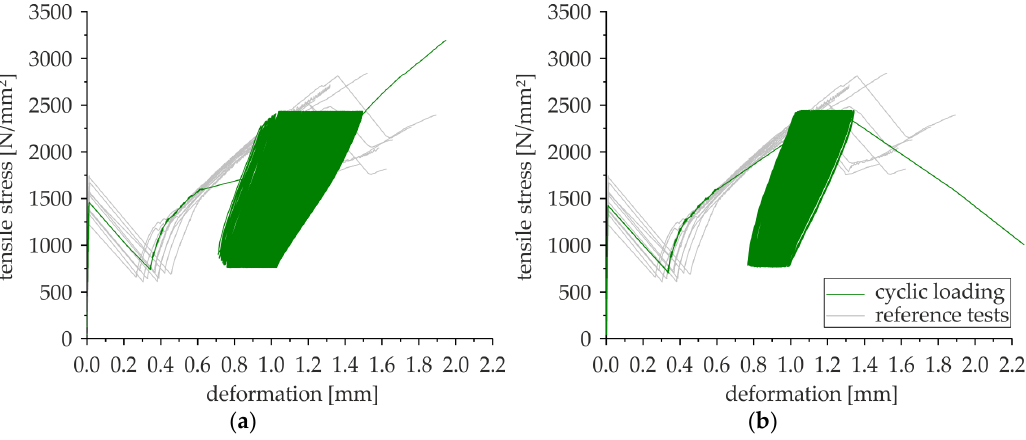
Figure A3. Cyclic stress–deformation curves (here: anchorage length = 4 a ): ( a ) non-failed specimen; ( b ) failed specimen (load cycles: